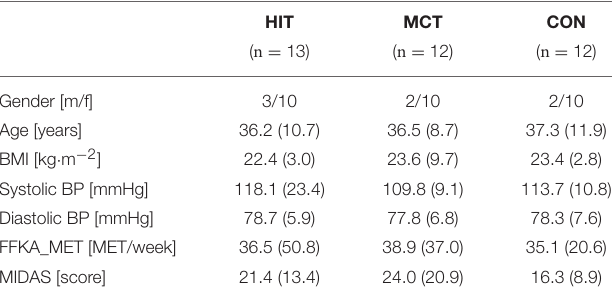
TABLE 1 | Baseline data of the participants for both intervention groups (HIT and MCT) and the control group